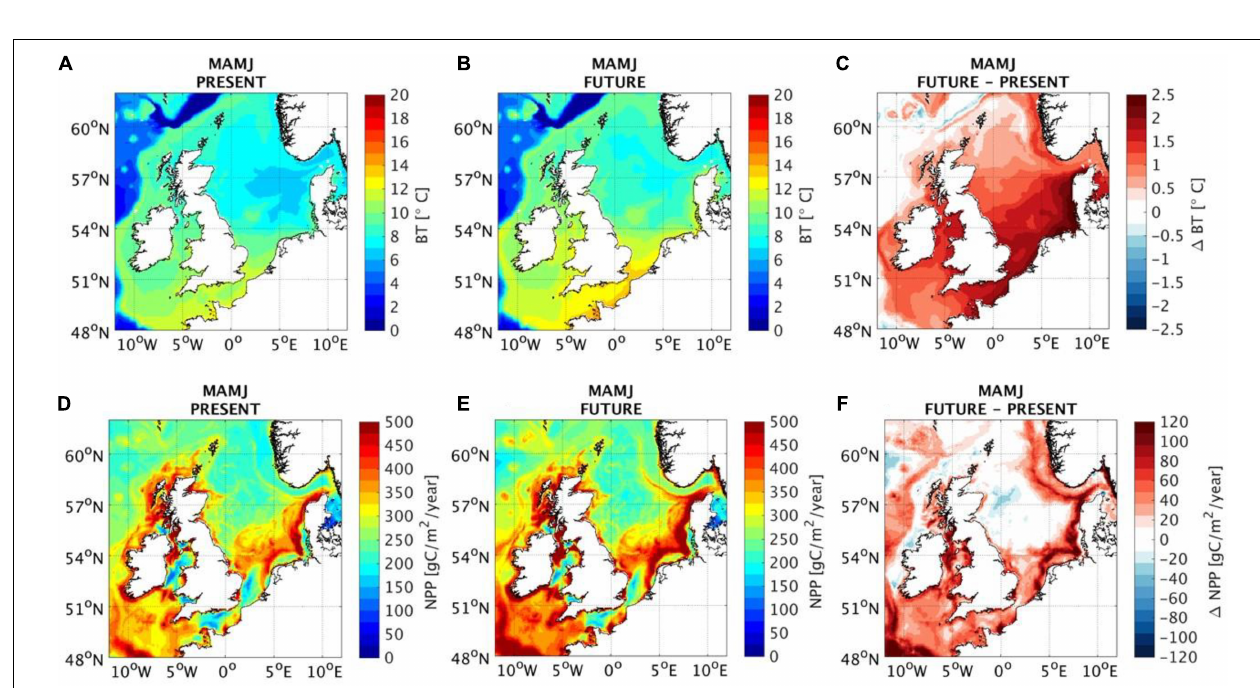
FIGURE 2 | Present spring-summer (March–April–May–June: MAMJ) from a mean of 25 years (1989–2014) (A,D) , future under “business as usual” (worst case) greenhouse-gas emissions scenario in 2050 from a mean of projected yearly outcomes from 2037 to 2062 (B,E) and difference between present and future (C,F) for bottom temperature (BT) and net primary production (NPP). Data provided from the Atlantic Margin Model 7 × 7 km (AMM7-NEMO) 3D baroclinic, hydrodynamic model, coupled with an ecosystem model ERSEM (Wakelin et al., 2015); for more information, see Sadykova et al. (2020).